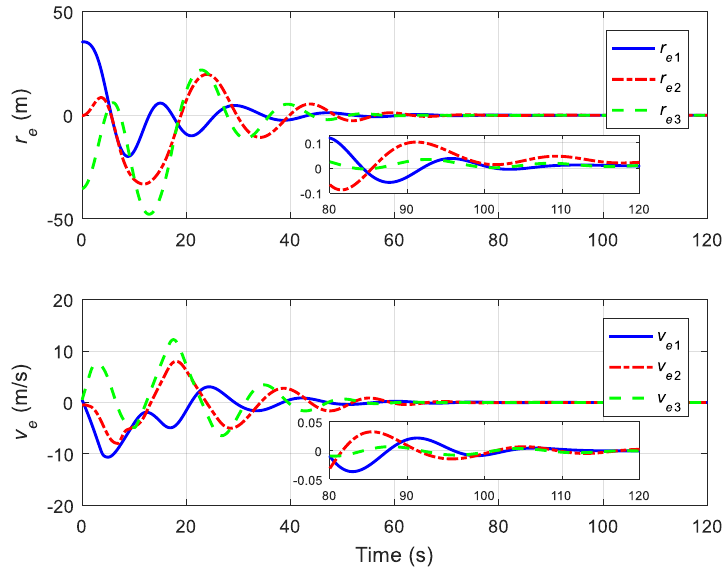
Figure 9. Relative position and velocity under the PD controller.